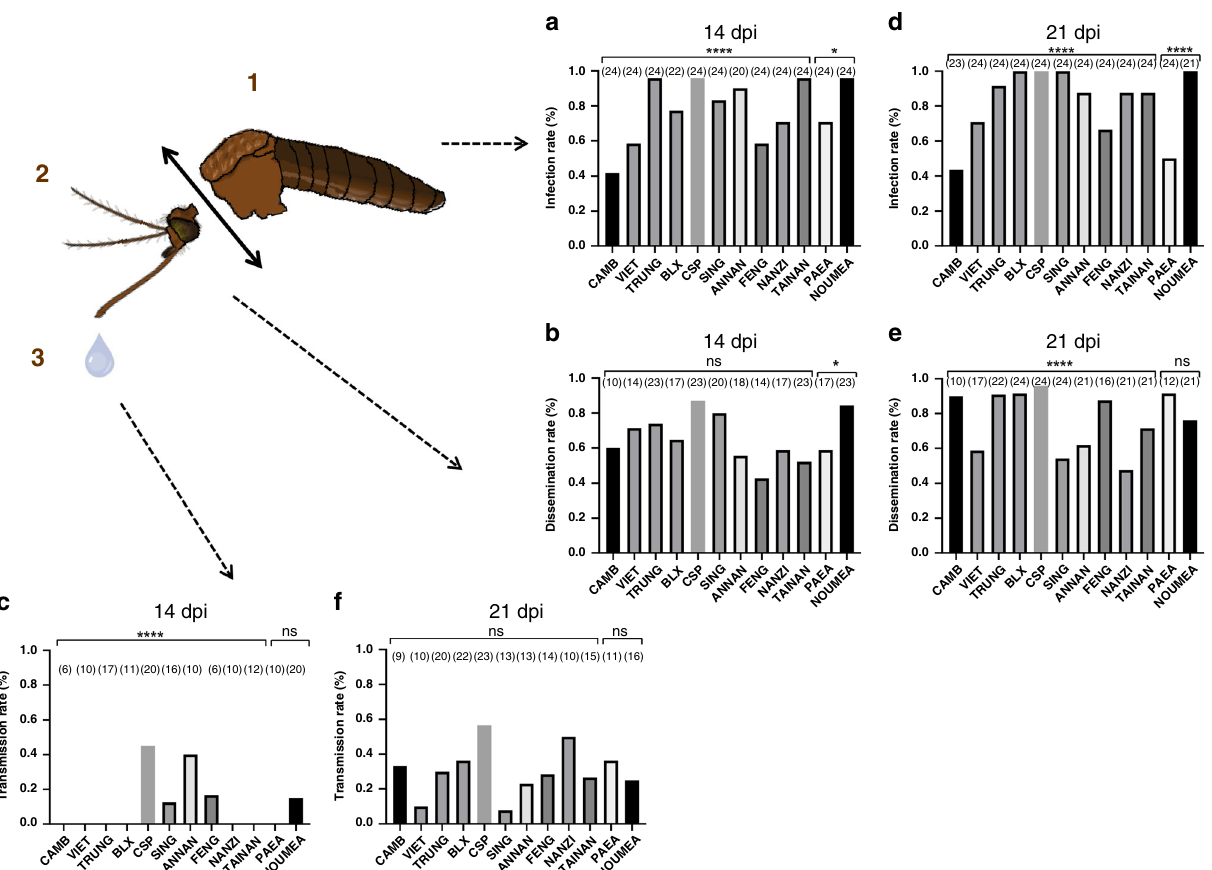
Fig. 1 Vector competence of 12 Aedes aegypti populations assessed 14 and 21 days after an infectious blood meal containing 10 7 ffu/mL of YFV (West- African genotype). Batches of 20 – 24 mosquitoes were examined in each population for viral infection ( a , d ), dissemination ( b , e ), and transmission ( c , f ) by estimating respectively the proportion of mosquitoes with infected bodies (1), head (2), and saliva (3). Titrations were performed on C6/36 cells in 96-well plates. Viral particles were detected by FFA using a primary anti-YFV antibody and a secondary fl uorescent-conjugated antibody. Infection rate (IR) refers to the percentage of mosquitoes having an infected body among blood-fed mosquitoes. Dissemination rate (DR) is the percentage of mosquitoes with an infected head (containing viral particles having disseminated in the general cavity after crossing successfully the midgut) among mosquitoes with an infected body. Transmission rate (TR) corresponds to the percentage of mosquitoes with infectious saliva (viral particles having successively crossed the two anatomical barriers, midgut and salivary glands) among mosquitoes with infected head. Stars indicate statistical signi fi cance of comparisons by Fisher ’ s exact test (two- sided test; * P ≤ 0.05, **** P ≤ 0.0001). a **** P ≤ 0.0001, * P = 0.02; b *P0.042; c **** P ≤ 0.0001; d **** P ≤ 0.0001; e **** P ≤ 0.0001. ns (non-signi fi cant) indicates a lack of statistical signi fi cance ( P >0.05). In brackets are the numbers of mosquitoes tested. dpi days post-infection. Source data are provided in Supplementary Data 1 fi